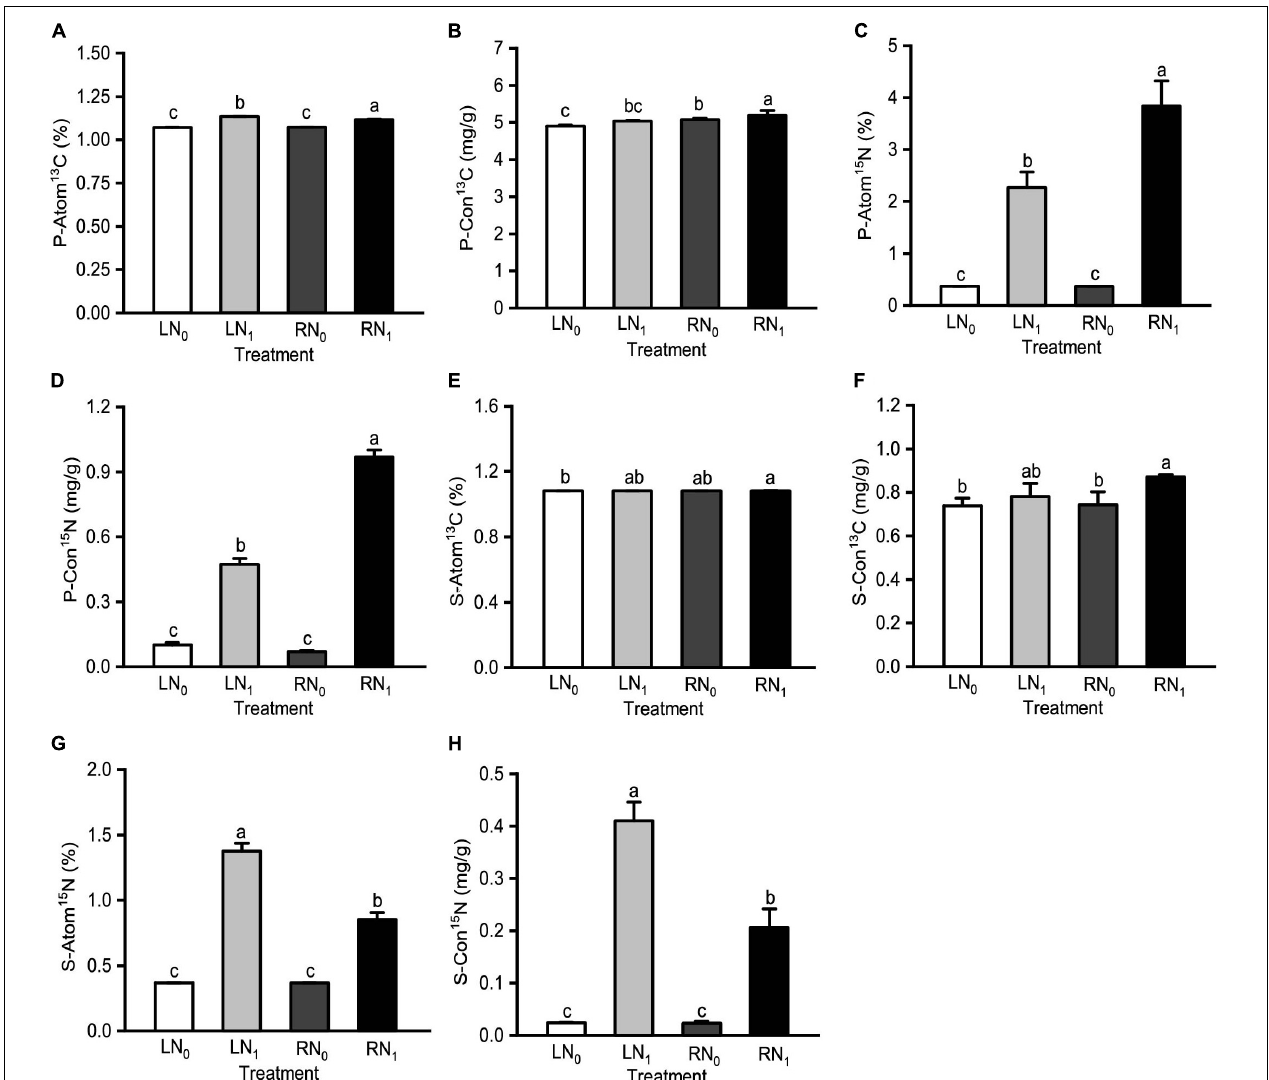
FIGURE 2 | Comparisons of (A) plant 13 C abundance (P-Atom 13 C), (B) plant 13 C absolute abundance (P-Con 13 C), (C) plant 15 N abundance (P-Atom 15 N), (D) plant 15 N absolute abundance (P-Con 15 N), (E) soil 13 C abundance (S-Atom 13 C), (F) soil 13 C abundance (S-Con 13 C), (G) soil 15 N absolute abundance (S-Atom 15 N), and (H) soil 15 N absolute abundance (S-Con 15 N) among different treatments. L and R were low and room temperature treatments, N 0 and N 1 were non-nitrogen and nitrogen treatments. Values were shown as means ± standard deviations (SD, n = 3). Different lowercase letters were indicated statistically significant differences between the four treatments at 0.05